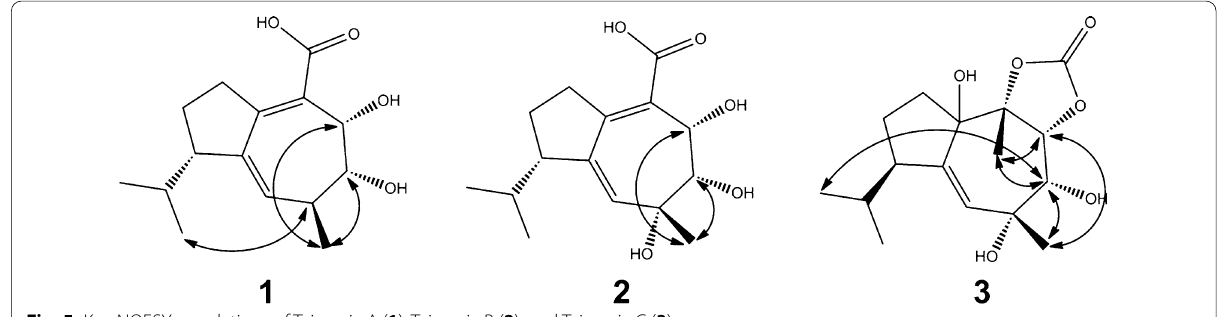
Fig. 5 Key NOESY correlations of Taiwania A ( 1 ), Taiwania B ( 2 ), and Taiwania C ( 3